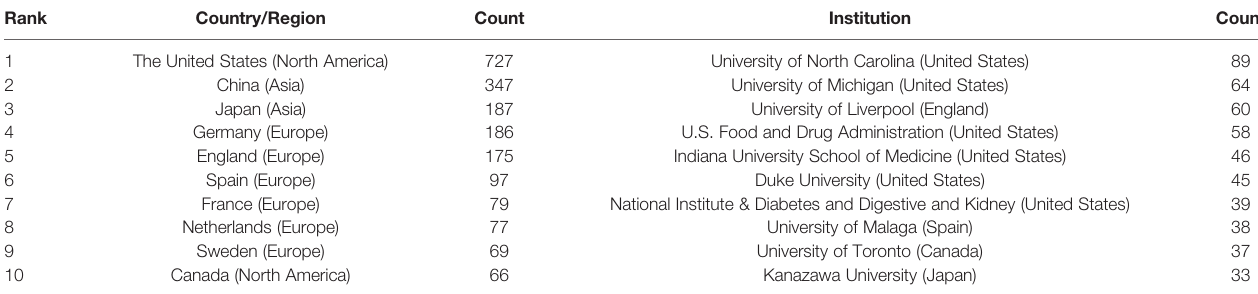
TABLE 1 | The top 10 countries/regions and institutions involved to DILI research. Rank